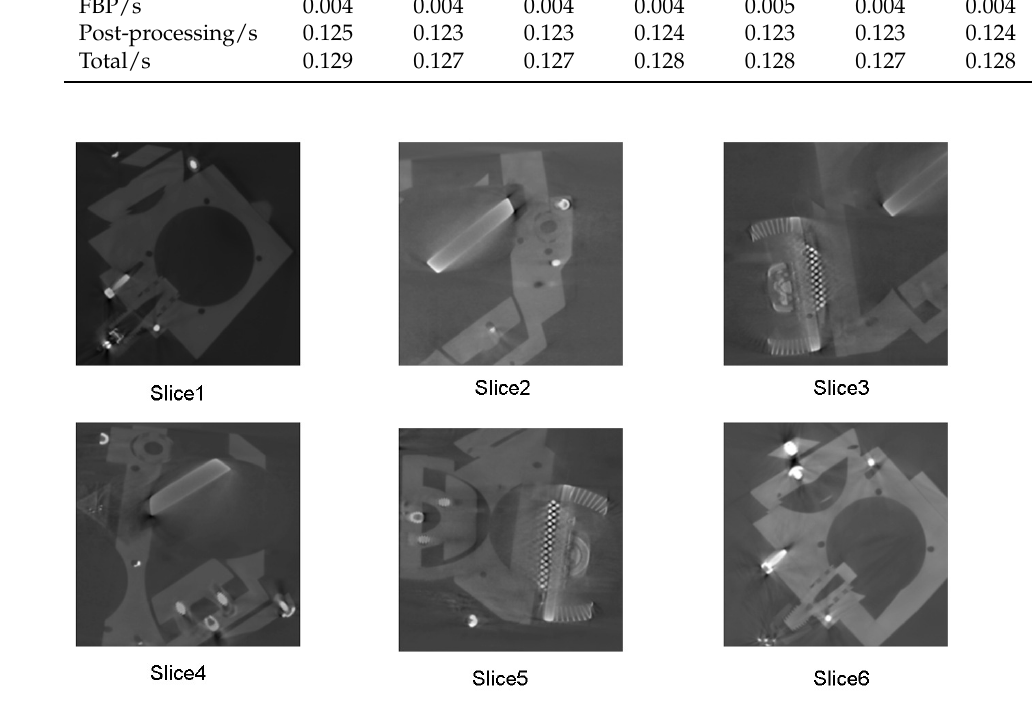
Figure 16. Slices for time consumption